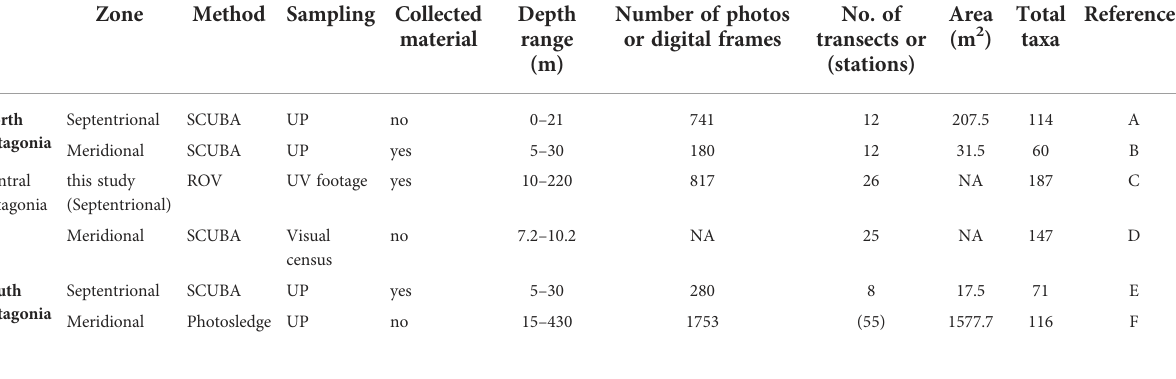
TABLE 3 Species richness (number of taxa) of selected investigations on benthic communities in the three main areas of the fjord and channel region in Chilean Patagonia, sorted by septentrional and meridional zones for each area.